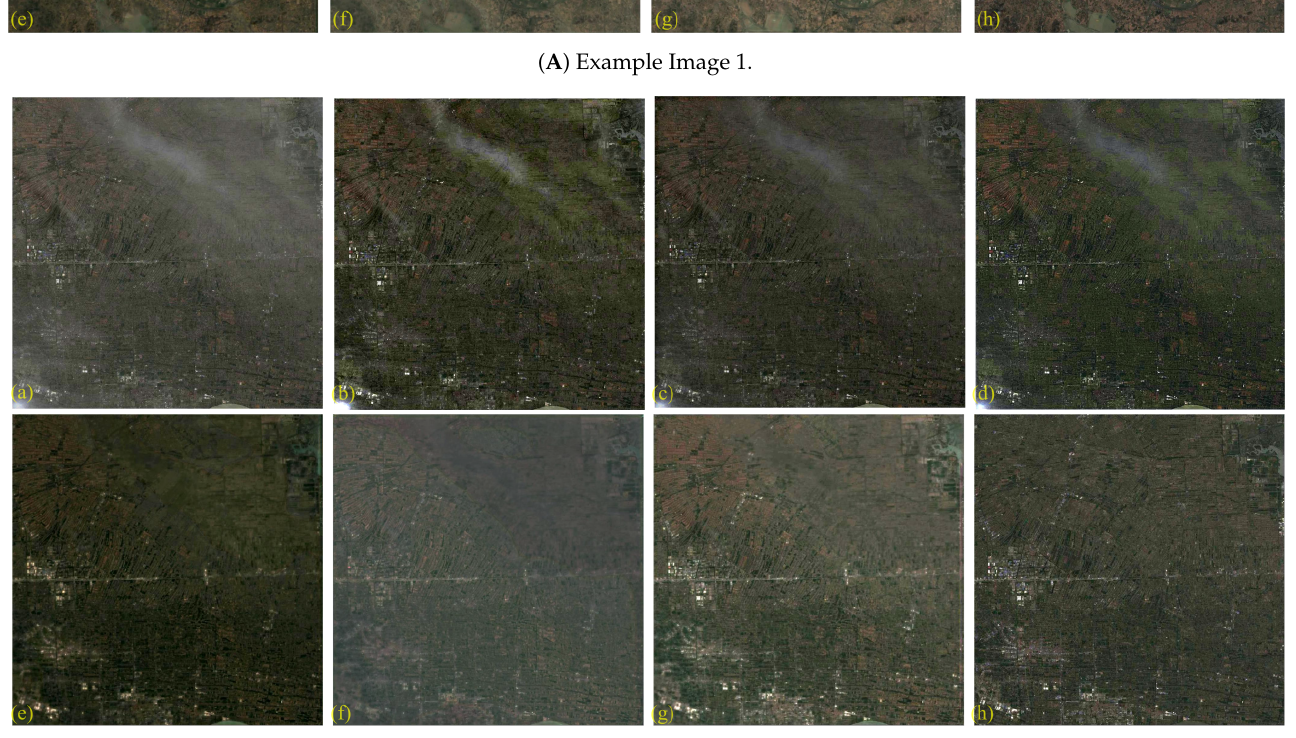
Figure 9. Dehazing results on images with slight haze interference. ( a ) Hazy image; ( b ) DCP; ( c ) DehazeNet; ( d ) AOD-NET; ( e ) GridDehazeNet; ( f ) MSBDN; ( g ) proposed method; ( h ) haze- free